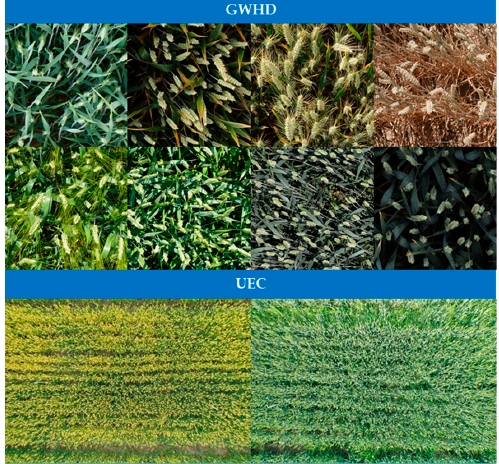
Figure 11. Representative images of GWHD dataset and UEC